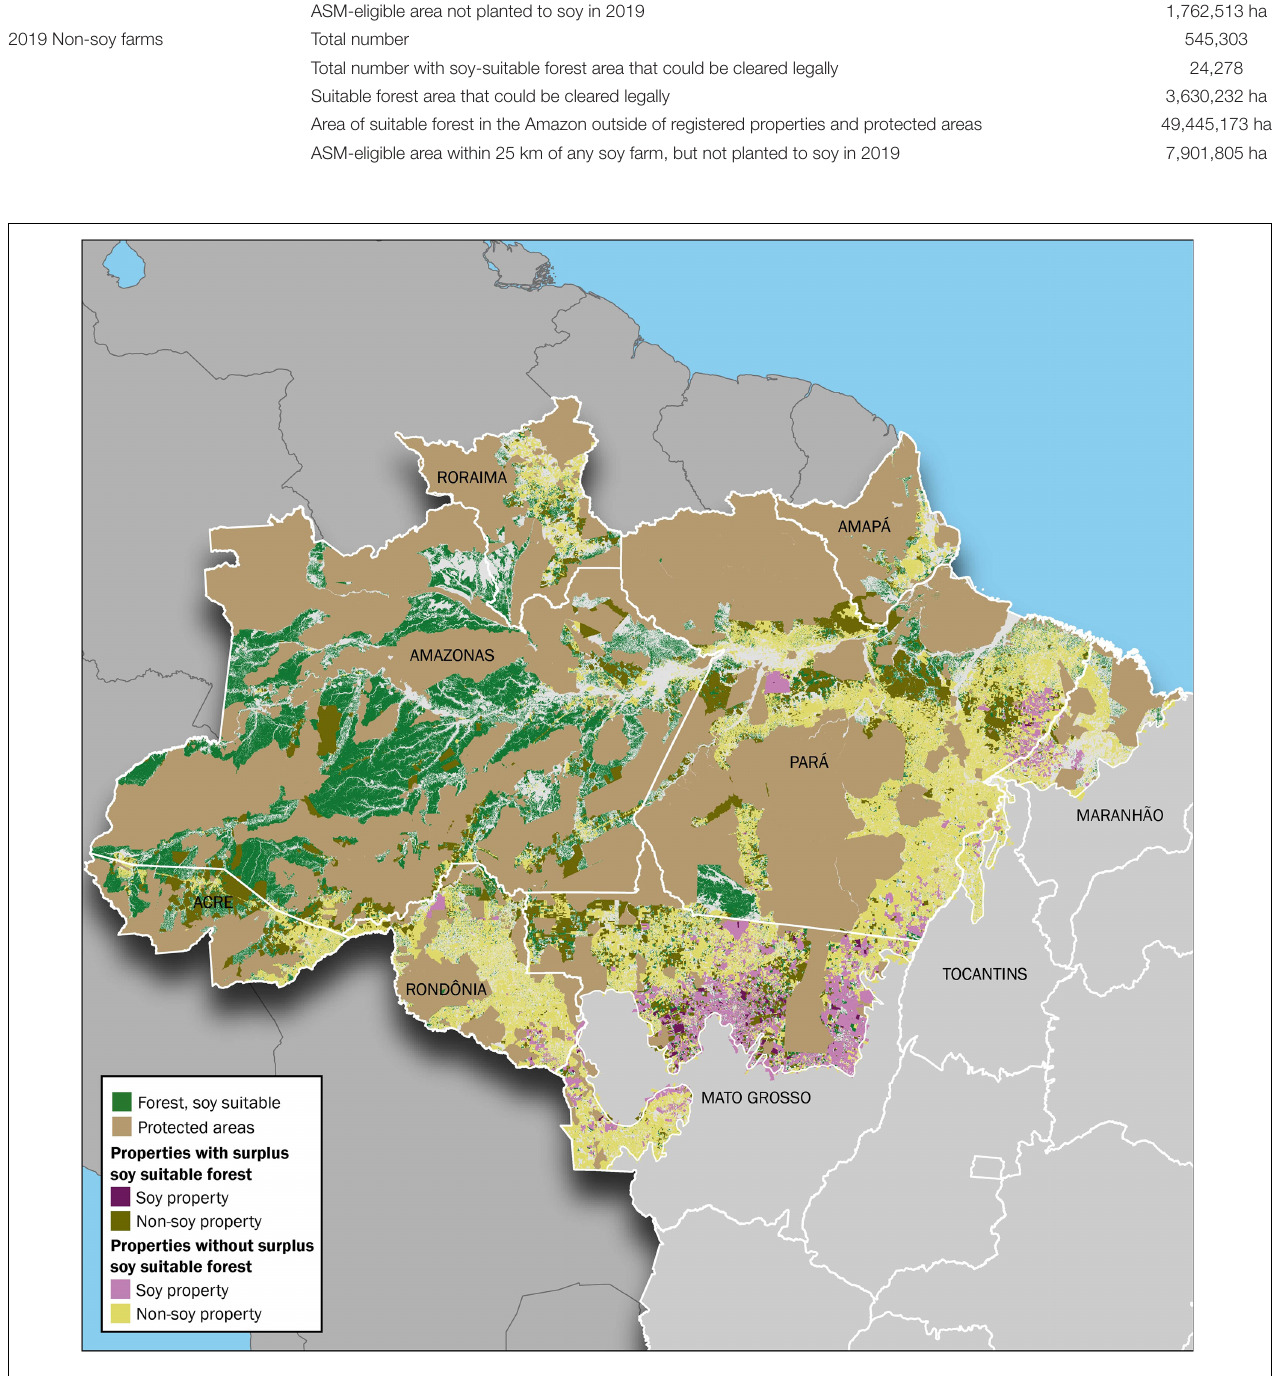
Frontiers in Forests and Global Change |